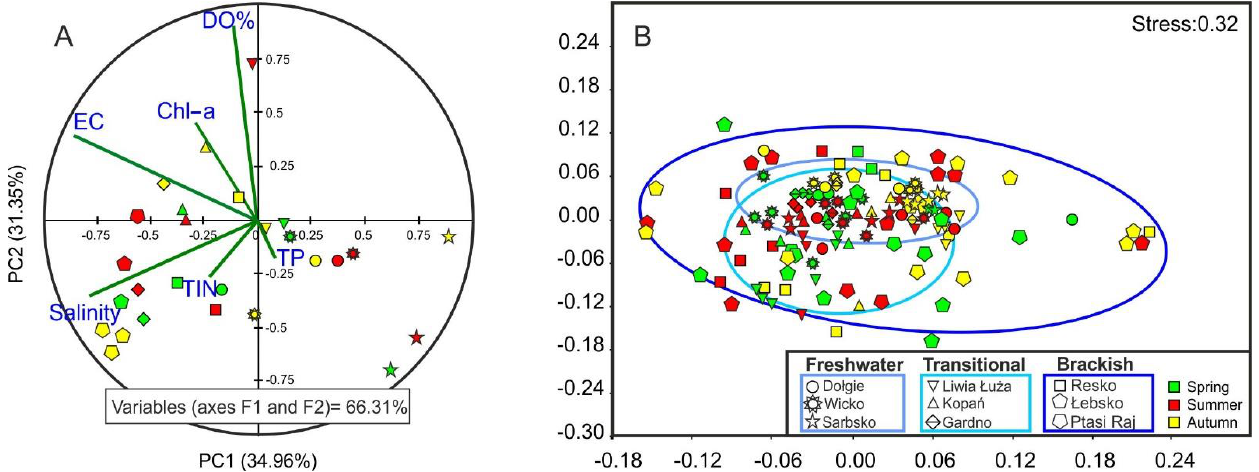
Figure 2. ( A ) PCA ordination on environmental parameters (salinity, EC, dissolved oxygen, Chl-a, TP and TIN) and ( B ) multidimensional scaling (MDS) plot based on species abundance.